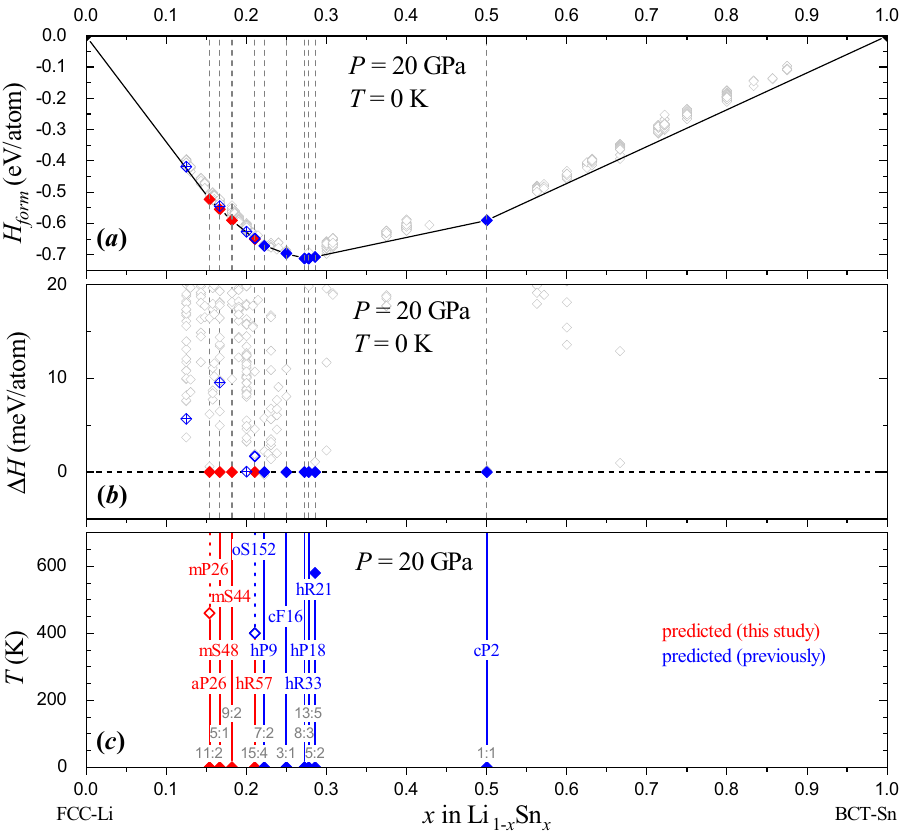
Fig. 4 The same as in Fig. 3, but at P = 20 GPa. a The convex hull at T = 0 K. b The distance from the convex hull at T = 0 K. c The temperature range of phase stability. The four putative ground states in red identi fi ed with our NN-based evolutionary searches rede fi ne the Li-rich end of the previously proposed T = 0 K convex